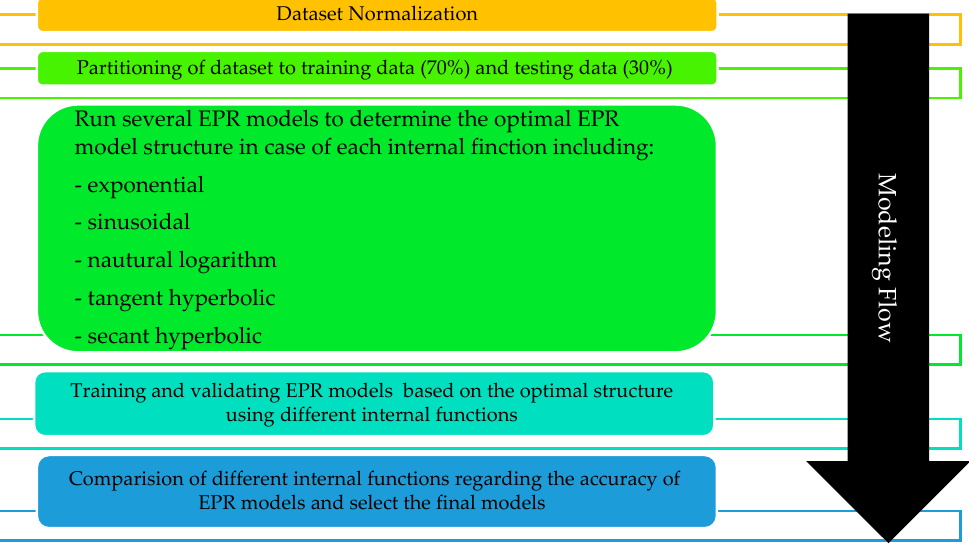
Figure 3. Overall procedure for developing EPR models.